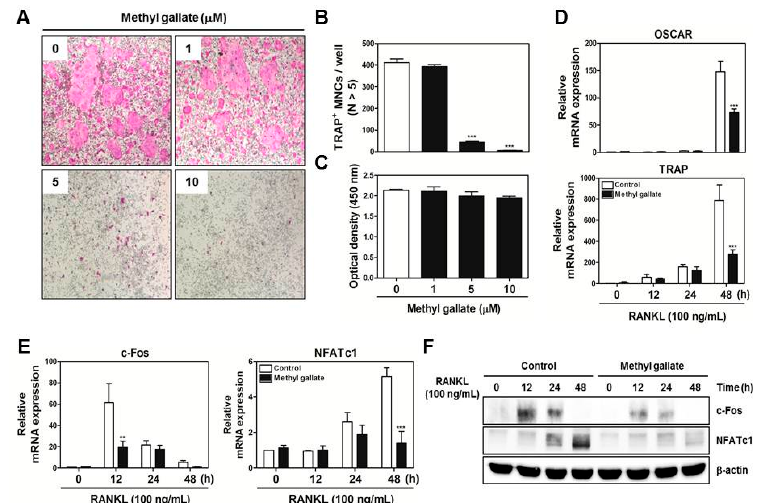
Figure 1 . Methyl gallate inhibits receptor activator of nuclear factor κ B ligand (RANKL)-induced osteoclastic differentiation through downregulation of c-Fos and NFATc1. ( A ) bone marrow macrophages (BMM)s were cultured with M-CSF (30 ng/mL) and RANKL (100 ng/mL) in the presence or absence of the indicated concentrations of methyl gallate. The cells were fixed, permeabilized, and stained with a tartrate resistant acid phosphatase (TRAP) solution. TRAP-positive multinucleated cells (MNCs) were photographed under a light microscope at the indicated magnification (10×); ( B ) The number of TRAP-positive MNCs (nuclei >5) was determined in these cultures. *** p < 0.001 vs. DMSO-treated control group; ( C ) BMMs were seeded into 96-well plates and cultured for 3 days in the presence of M-CSF (30 ng/mL) with the indicated concentrations of methyl gallate. After that, cell viability was analyzed by an tetrazolium salt sodium 3 ′ -{1-[(phenylamino)-carbonyl]-3,4-tetrazolium}- bis (4-methoxy-6-nitro)benzene-sulfonic acid hydrate (XTT) assay; ( D ) BMMs were preincubated with or without methyl gallate (10 µ M) for 1 h in the presence of M-CSF (30 ng/mL) and then stimulated with RANKL (100 ng/mL) for the indicated periods. The mRNA expression levels of osteoclast-associated receptor (OSCAR) and TRAP were analyzed by quantitative real-time RT-PCR. *** p < 0.001 vs. the control group at the corresponding time point; ( E ) The mRNA expression levels of c-Fos and NFATc1 were analyzed by quantitative real-time RT-PCR. ** p < 0.01; *** p < 0.001 vs. control group at the corresponding time point; ( F ) BMMs were preincubated with or without methyl gallate (10 µ M) for 1 h in the presence of M-CSF (30 ng/mL) before RANKL (100 ng/mL) stimulation at the indicated time points. Whole-cell lysates were analyzed by Western blotting with the indicated antibodies. β -Actin served as internal